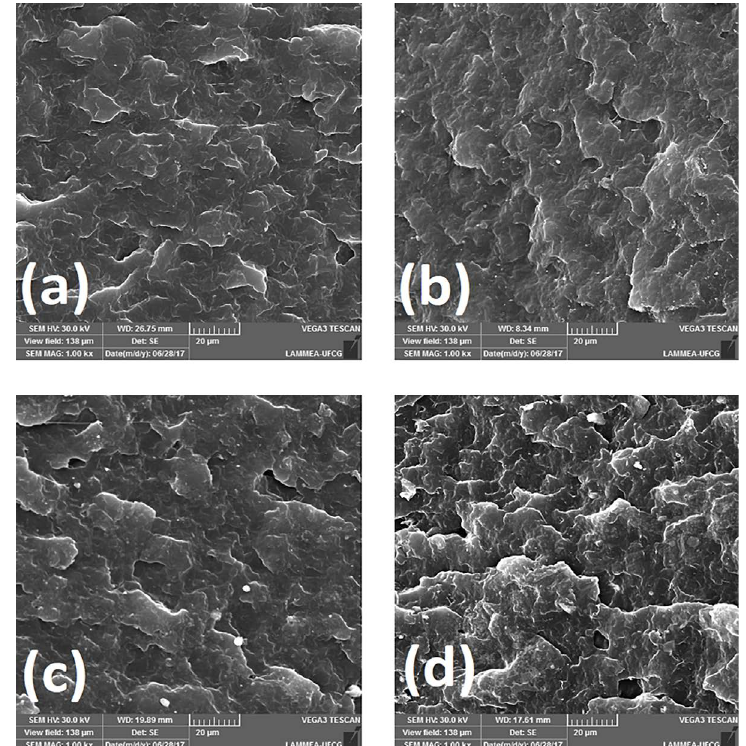
, (c) PP H503 + 30% R BB